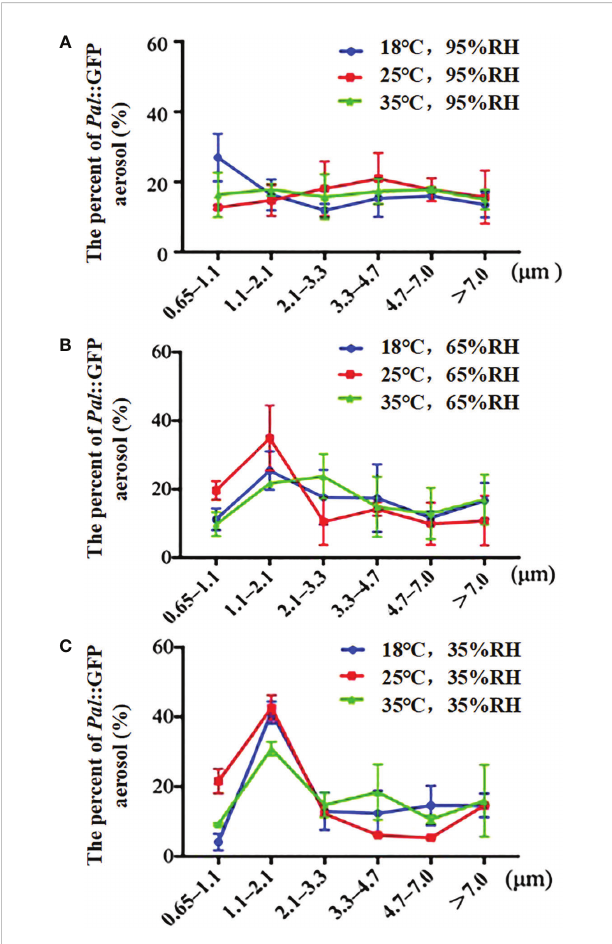
FIGURE 4 Effect of temperature and relative humidity (RH) on the size distribution of Pseudomonas amygdali pv. lachrymans ( Pal ) particles in the aerosol chambers. The size distribution of Pal ::GFP aerosol were detected immediately after aerosolizing Pal ::GFP suspension (10 8 CFU/ mL) for 30 min at the fl owrate of 12 L/min by a six -jet Collision nebulizer. Error bars represent the standard deviations (SDs) of three